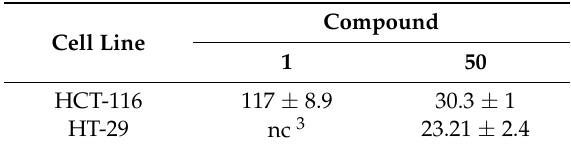
Table 8. Anticancer activities of compound 50 compared to quercetin 1,2 .